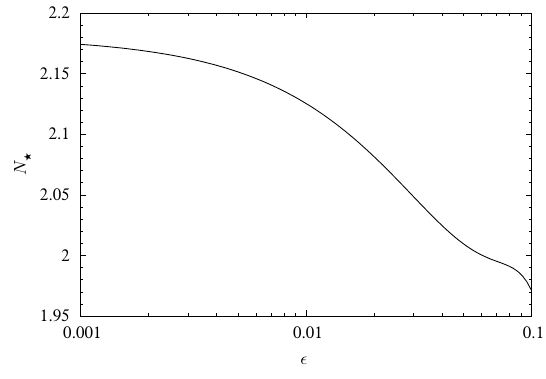
Figure 3 . The critical value, N ? , of the topological charge of the axially symmetric baby Skyrmion, as a function of (cid:15) . N ? corresponds to the smallest energy per topological charge and hence the globally stable axially symmetric